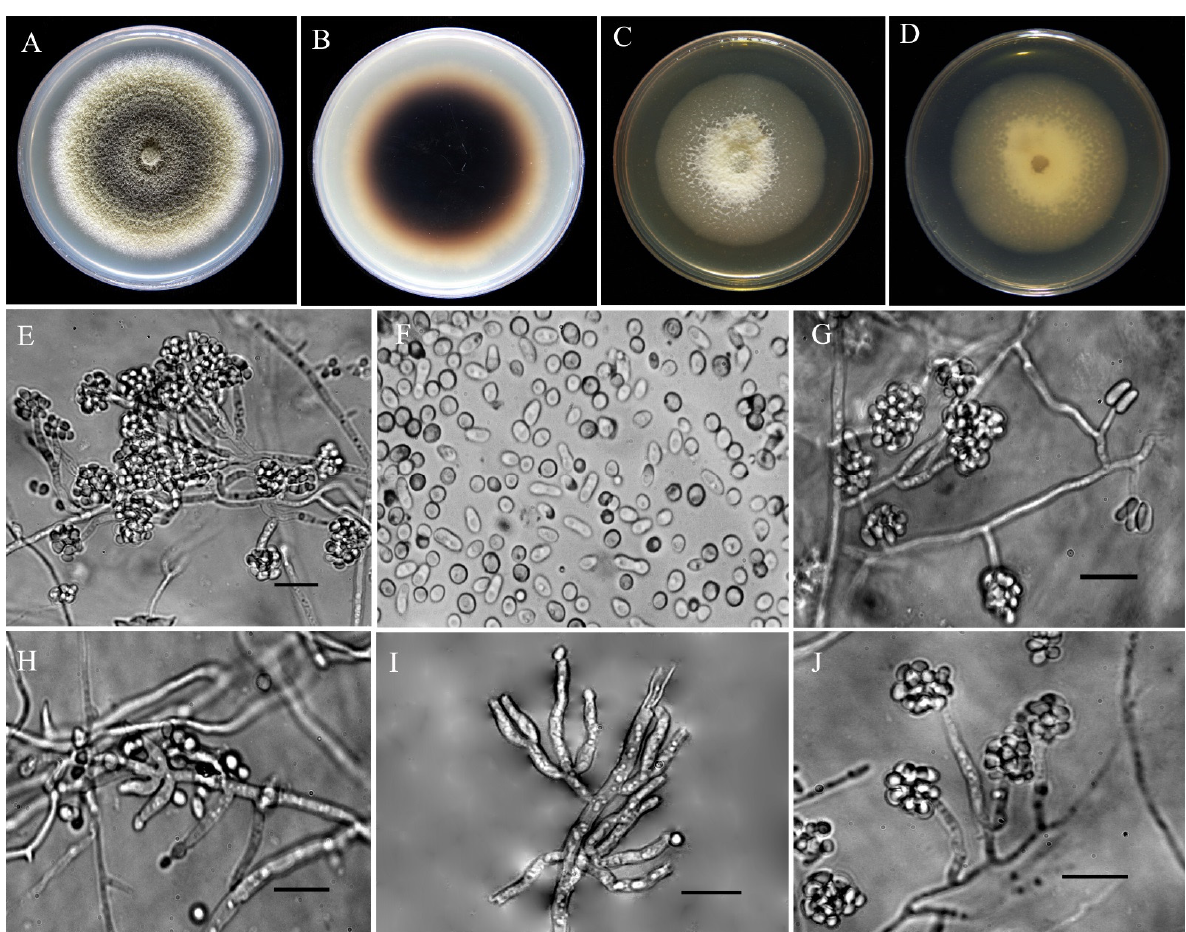
Figure 6. Cultural and asexual morphological characteristics of Stilbocrea banihashemiana sp. nov. from infected fig and loquat trees in Fars Province, Iran. ( A , B ): Colonies on PDA after 14 days at 25 °C under a 12-h photoperiod, obverse and reverse side view, respectively. ( C , D ): Colonies on MEA after 14 days at 25 °C under a 12-h photoperiod obverse and reverse side view, respectively. ( E ): Abundant globose conidia produced by phialides and long-branched conidiophores. ( F ): Small, smooth, hyaline, and unicellular conidia, in two different forms globose and allantoid. ( G , J ): Comparison of short and long phialides, respectively. ( H , I ): Long, branched, and lageniform to cylindrical phialides that formed terminally and laterally on conidiophores. Bar = 10 µ